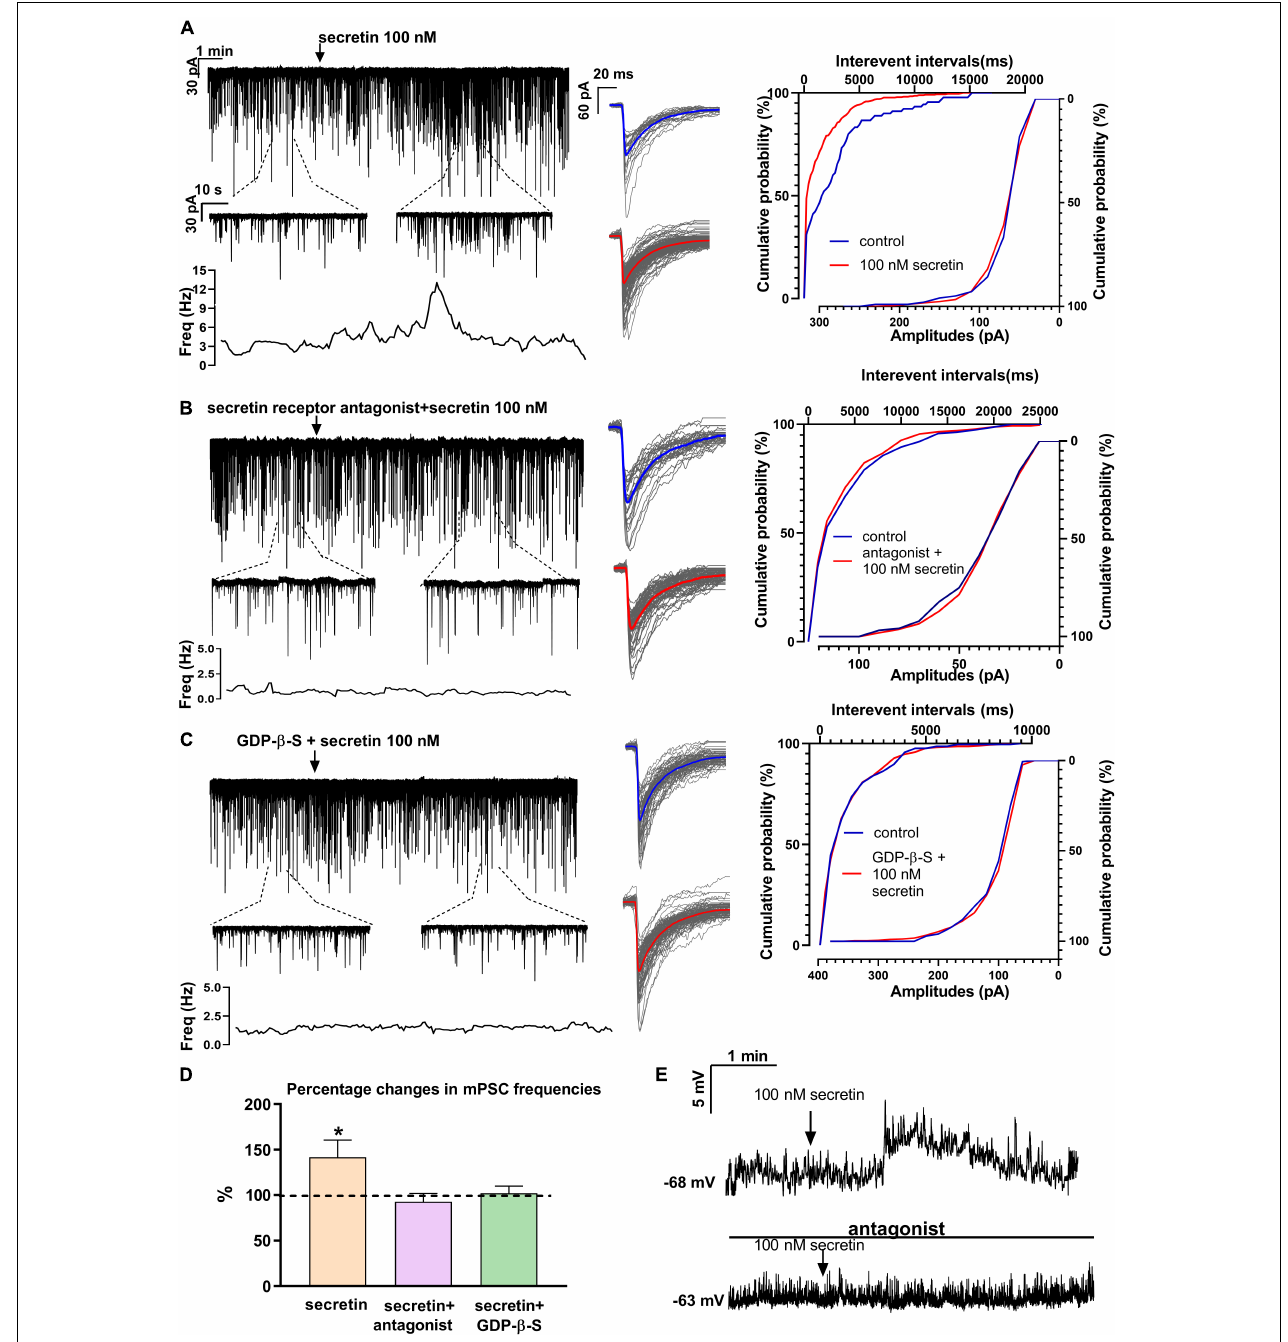
FIGURE 3 | Secretin elevates the frequency of mPSCs of GnRH neurons directly via secretin receptor. (A) Secretin (100 nM) increased the frequency of mPSCs in GnRH neurons, as shown in a representative recording, the 1 min zoomed periods, the frequency distribution and the cumulative probability of IEIs graphs. There was no change in the average amplitude or in the shape of the events representing the individual PSCs beside the recording. (B) Pretreatment of the brain slice with secretin receptor antagonist (Secretin 5–27) eliminated the effect of secretin on GnRH neurons. (C) Intracellular application of G-protein blocker, GDP- β -S also abolished the effect of secretin. (D) Bar graph shows that the effect of secretin was mediated via the G-protein coupled secretin receptor. (E) Depolarization in the resting potential is demonstrated in a 4 min period. Arrow shows application of secretin. The bottom recording, in the presence of secretin receptor antagonist shows no significant change after the administration of secretin (100 nM) ( ∗ p < 0.05). The inserts below the 15 min recordings are 1-1 min zoomed periods from the recordings before and after secretin administration. The frequency distribution is also presented under each recording. Average mPSCs next to the recording represent no change in the shape of events after secretin treatment. Cumulative probabilities of the interevent intervals and amplitudes are graphed next to the individual events. Arrow shows the administration of secretin ( ∗ p < 0.05).